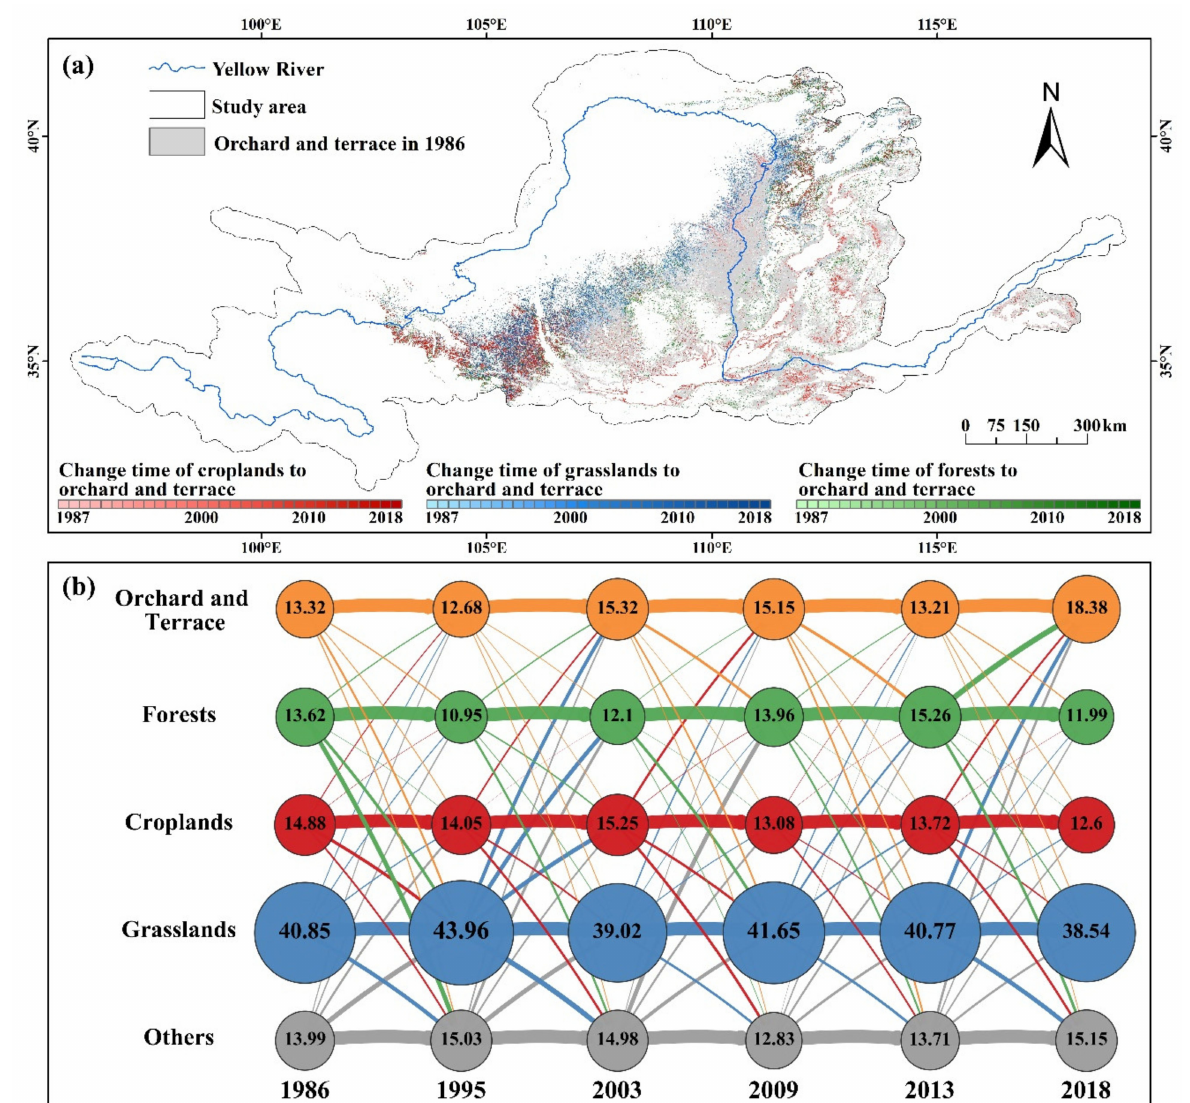
Figure 6. The transition of multiple land use/cover classes to orchard and terrace (OT). ( a ) Spatiotemporal distribution of the transition of forests, grasslands, and croplands to OT. ( b ) Land use/cover transition network of all the pixels in the study area for different periods. The numbers within the cycles in Figure 6b are the area (10 4 km 2 ) of each class in the corresponding year. The lines represent the amount of land use/cover transition area and their colors are the same as the source of